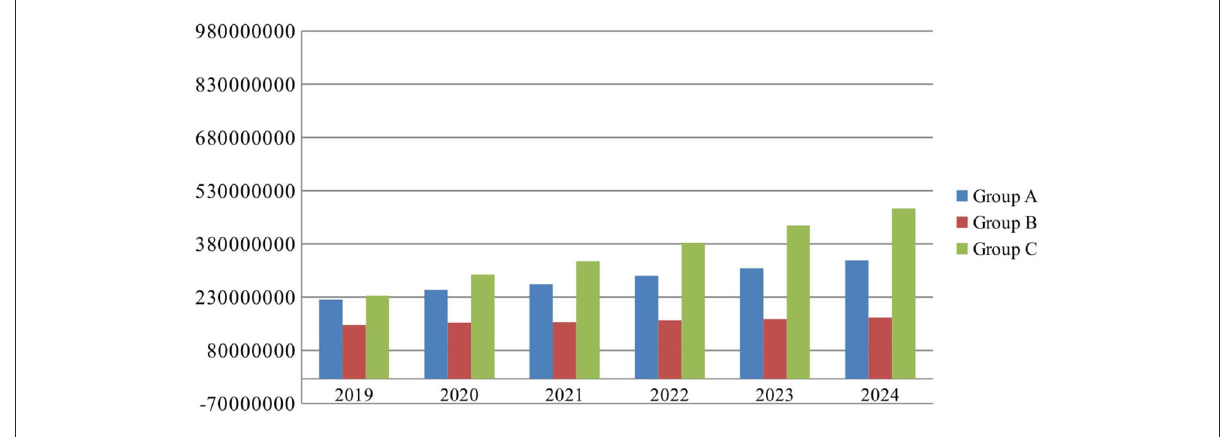
FIGURE2 Expenditures forecast for